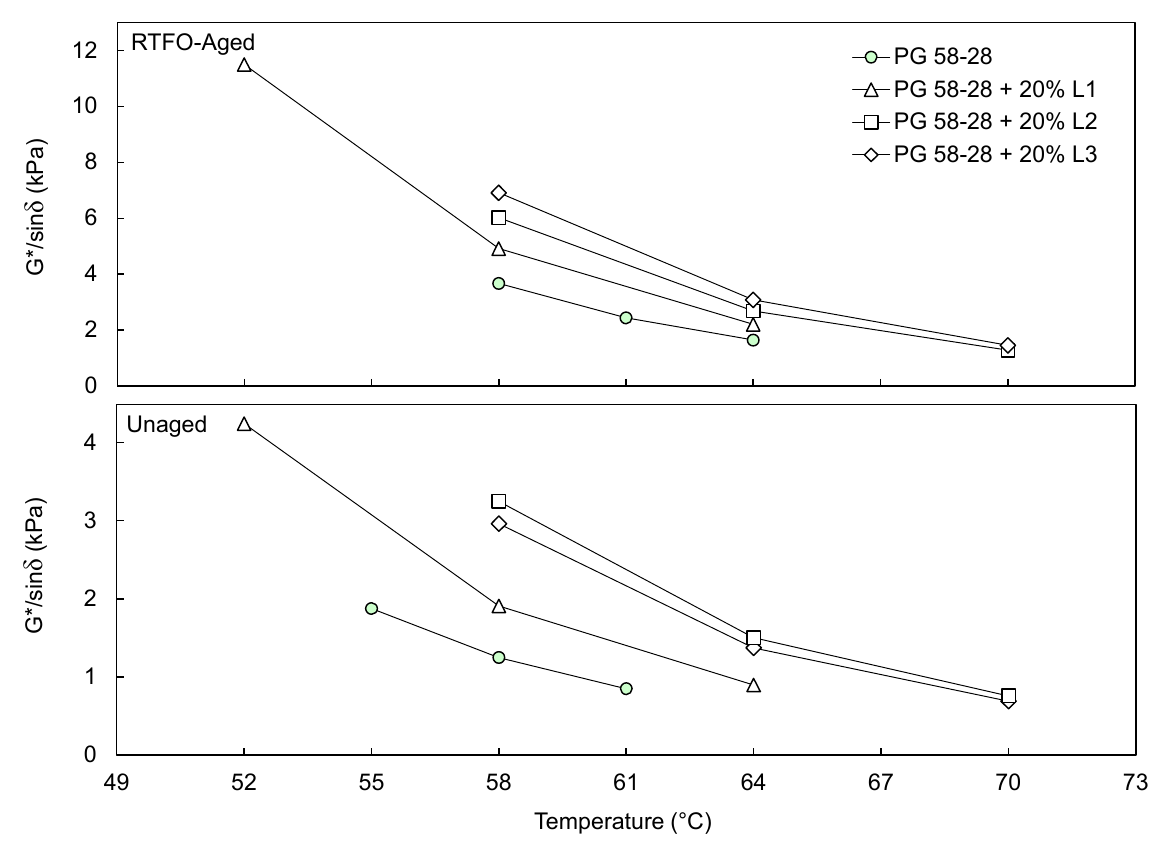
Figure 4. Rutting Factors (G*/sin δ ) of Unaged and RTFO-aged PG 58-28 and that Containing Different Amounts of L1, L2, and L3 Measured at Different Temperatures.